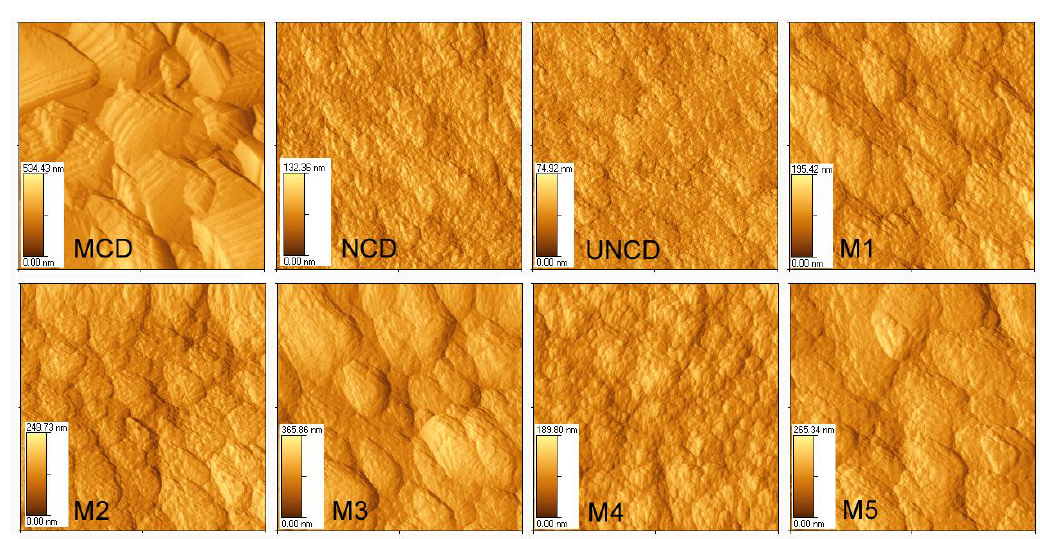
Figure 5. AFM images of various coatings surfaces, revealing differences in surface topography of multilayered coatings in comparison to single-layered MCD, NCD, and UNCD coatings.